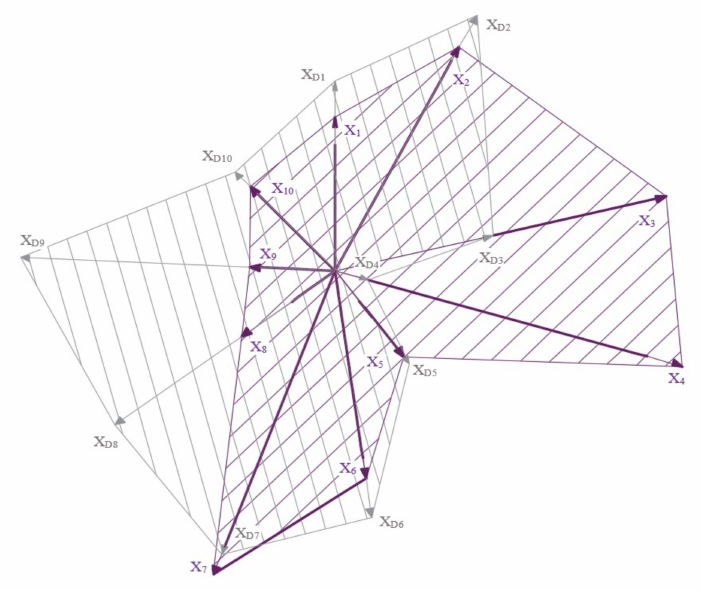
Figure 4. Graphic interpretation of the vector components for mixture